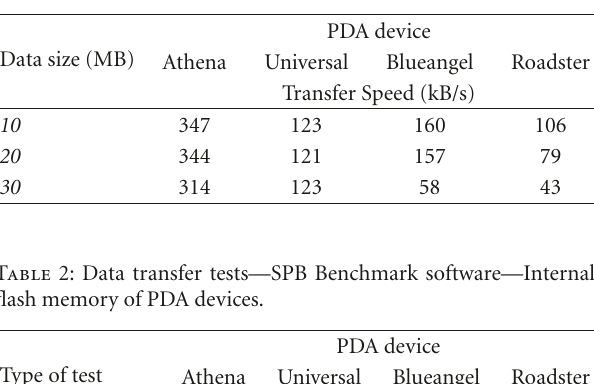
Figure 1: A data communication way—from server database to PDA display.